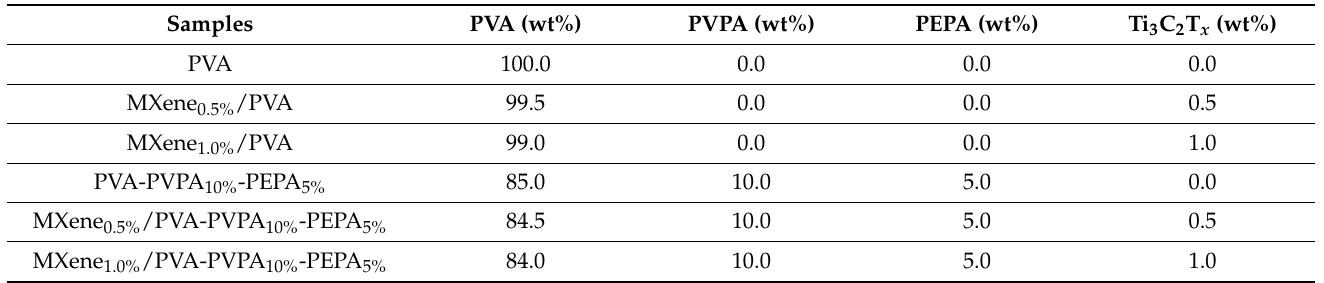
Table 1. Formulation of MXene/PVA